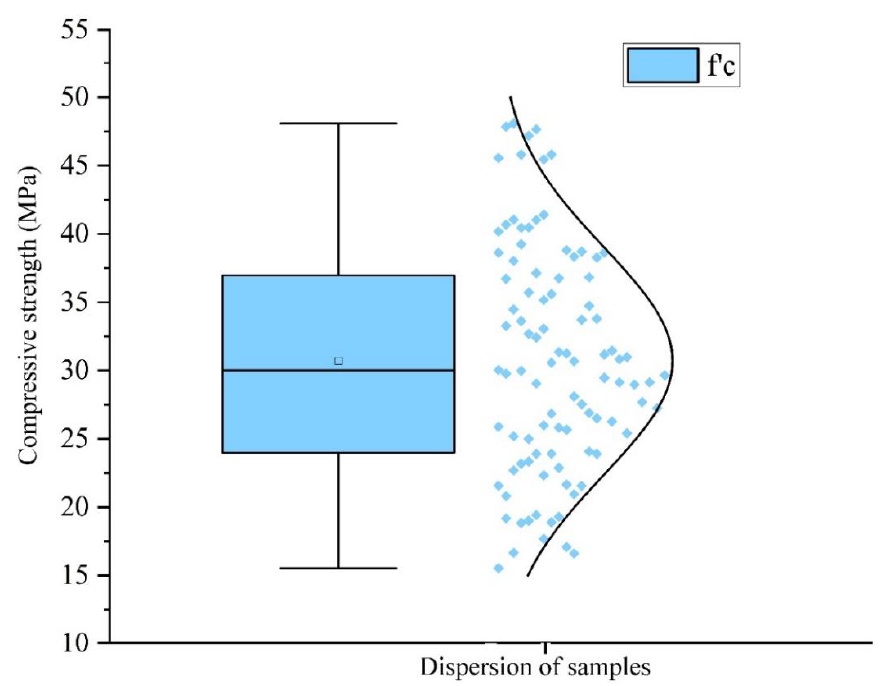
Figure 6. Distribution plot for the input parameter (compressive strength).